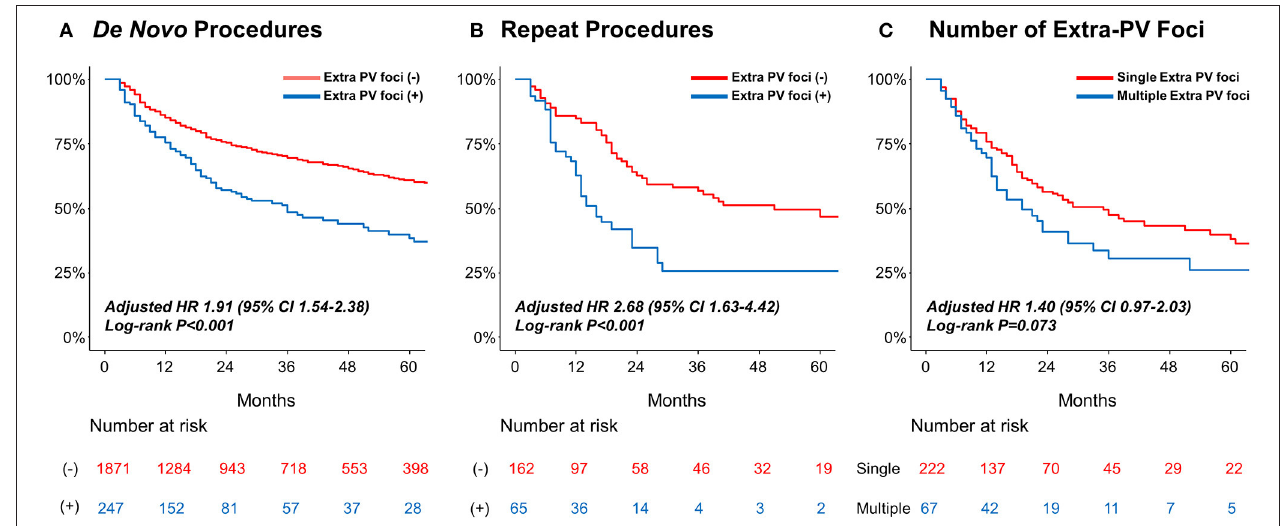
FIGURE 3 | Kaplan–Meier analyses of the AF recurrence-free survival (A) according to extra-PV triggers in the de novo AFCA; (B) according to the extra-PV triggers in the repeat AFCA; and (C) according to the number of extra-PV triggers. AF, atrial